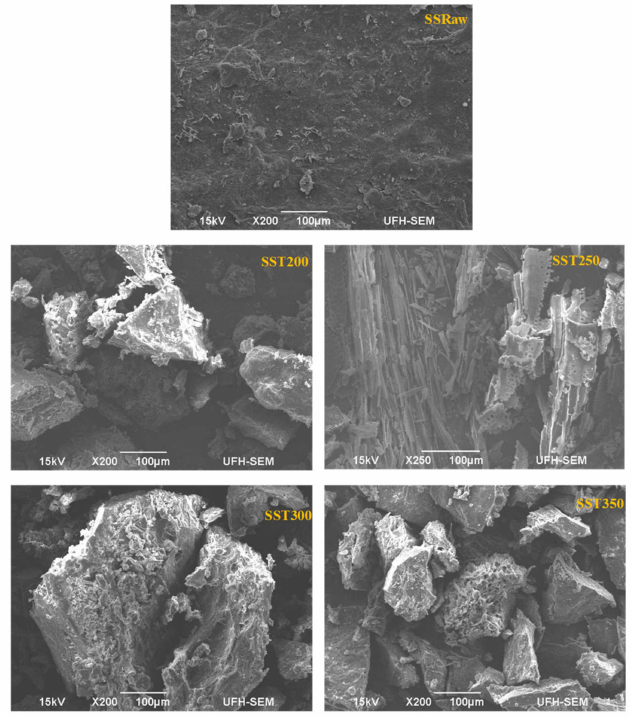
Figure 5. SEM images of raw sewage sludge (SSRaw) and torrefied sewage sludge at 200 ◦ C (SST200),